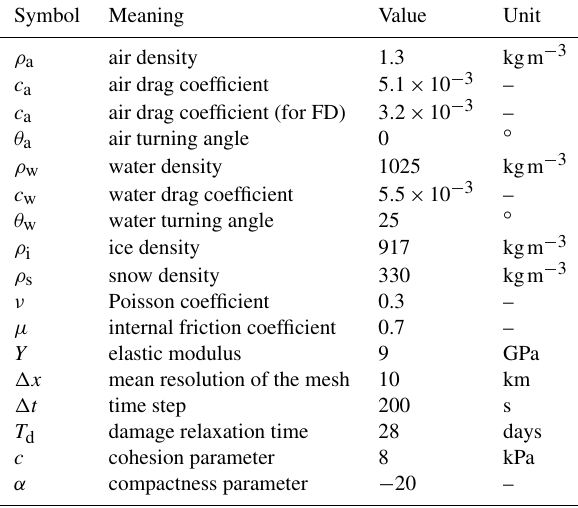
Table 1. Parameters used in the model with their values for the sim- ulations performed for this